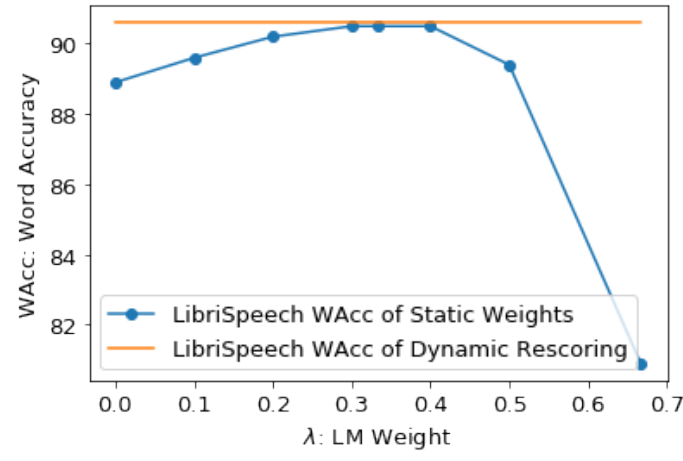
Figure 7. Results on LibriSpeech.